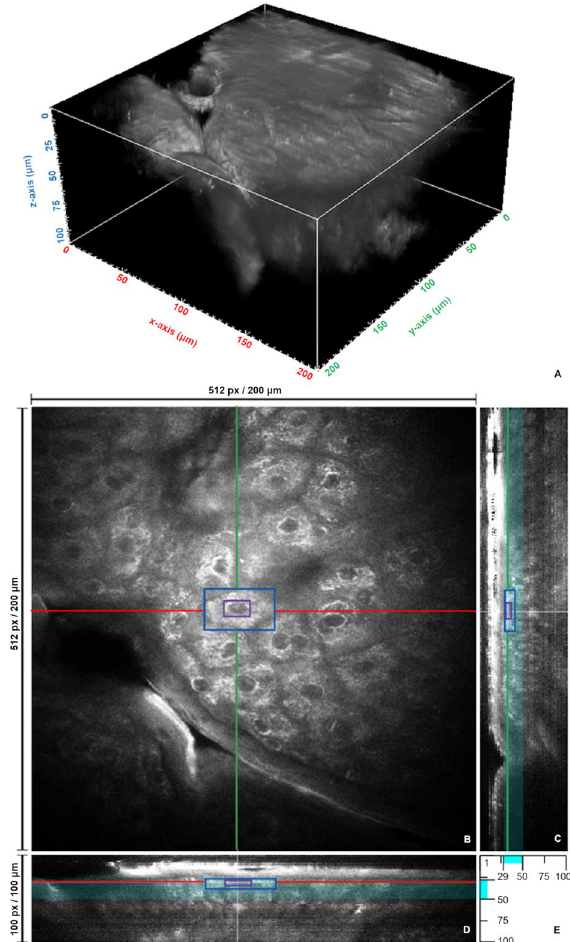
Figure 1. Image data. ( A ) 3D representation of the image stack with a size of 200 × 200 × 100 μm 3 ; ( B ) X–Y- plane in depth of 31 μm with cell bounding box (blue), nucleus bounding box (violet), intersection line of Y–Z-plane in ( C ) (green), and intersection line of X–Z-plane in ( D ) (red); ( C ) cross-section in Y–Z-direction; ( D ) cross-section in X–Z-direction; and ( E ) visualization of the considered cell-containing Z-layer interval in X–Z- and Y–Z-planes (cyan bars) with upper (29 μm) and lower (50 μm)